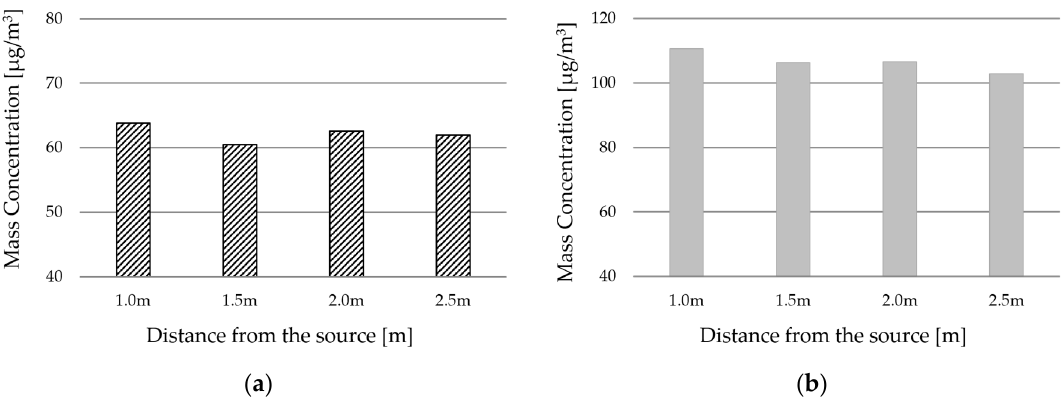
Figure 10. PM concentration of living room by distance from the source: ( a ) concentration in the living room; ( b ) concentration in the kitchen.